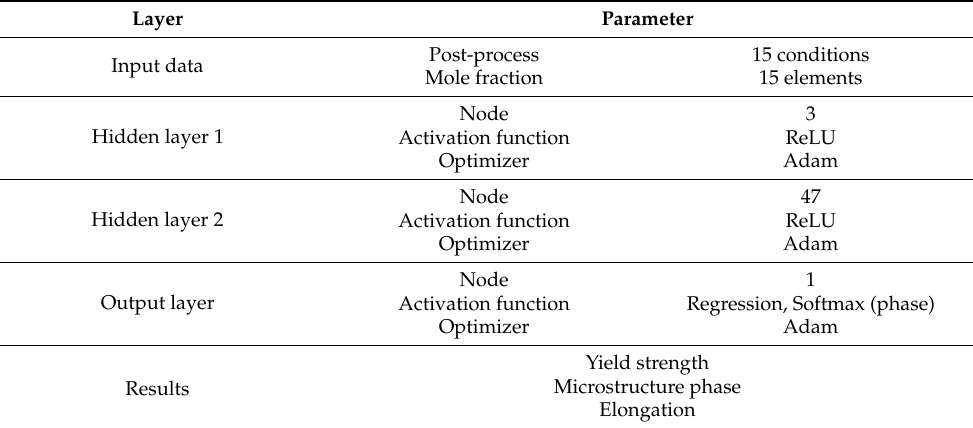
Table 2. Particular parameter used in artificial neural network prediction model on all layers.